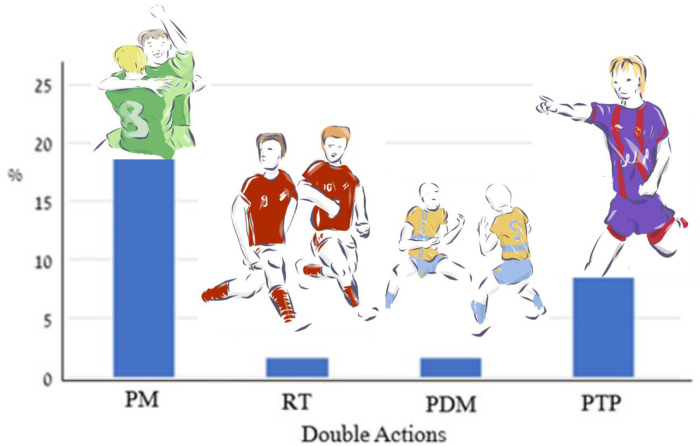
Percent of double players’ celebration acts (K = 4; # of actions = 114) in 366 goal celebrations.Index: PM–Pair movements; RT–Running together; PDM–Predetermined movements; PTP–Pointing toward the passer.